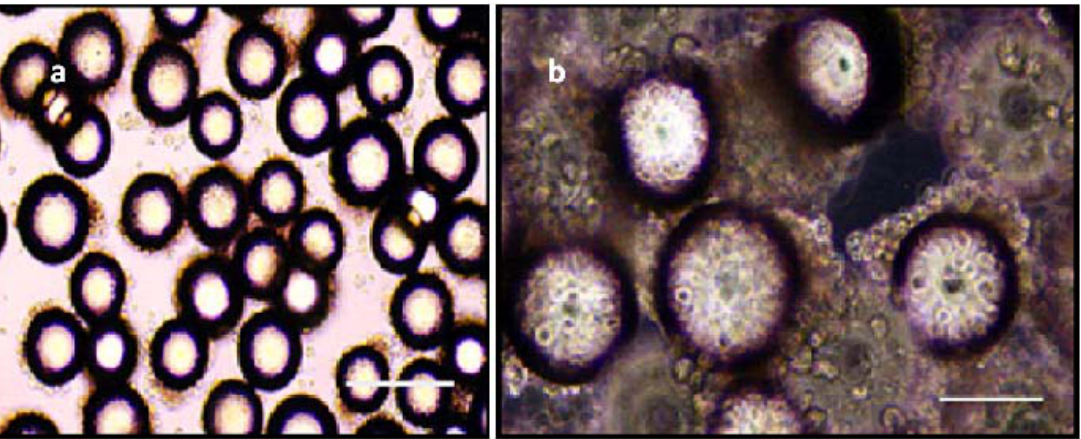
Figure 7. Tick cells grown on polystyrene beads. ( a ) Light micrograph of BmVIII ‐ SCC cells grown with polystyrene mi ‐ crocarrier beads (Corning ® Microcarriers) 10 days post ‐ inoculation (p.i.) in rotating cell culture system bioreactor; note early attachment of BMVIII ‐ SCC cells attached along lateral edges of individual beads and the halo ‐ like appearance and hollow core of polystyrene beads that reportedly have a proprietary electrostatic surface charge for improved cell attach ‐ ment; 100X view; scale bar = 50 μ m. ( b ) Light micrograph of BmVIII ‐ SCC cells 30 days p.i. surrounding polystyrene beads; 200X view. Scale bar = 25 μ m.